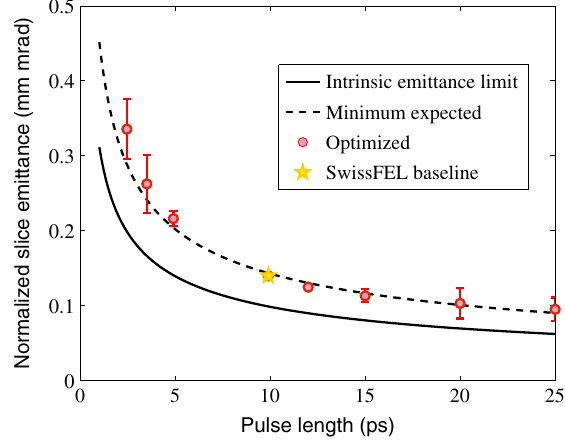
FIG. 10. Emittance in the central part of the bunch versus the laser pulse length. The theoretical limit of the intrinsic emittance ( 550 nm = mm assumed) and the expected emittance shifted by the same difference from the intrinsic value obtained for the 9.9 ps pulse length is also shown. The error bars represent the standard deviation of the emittance along the 3 = 4 of the total bunch length.